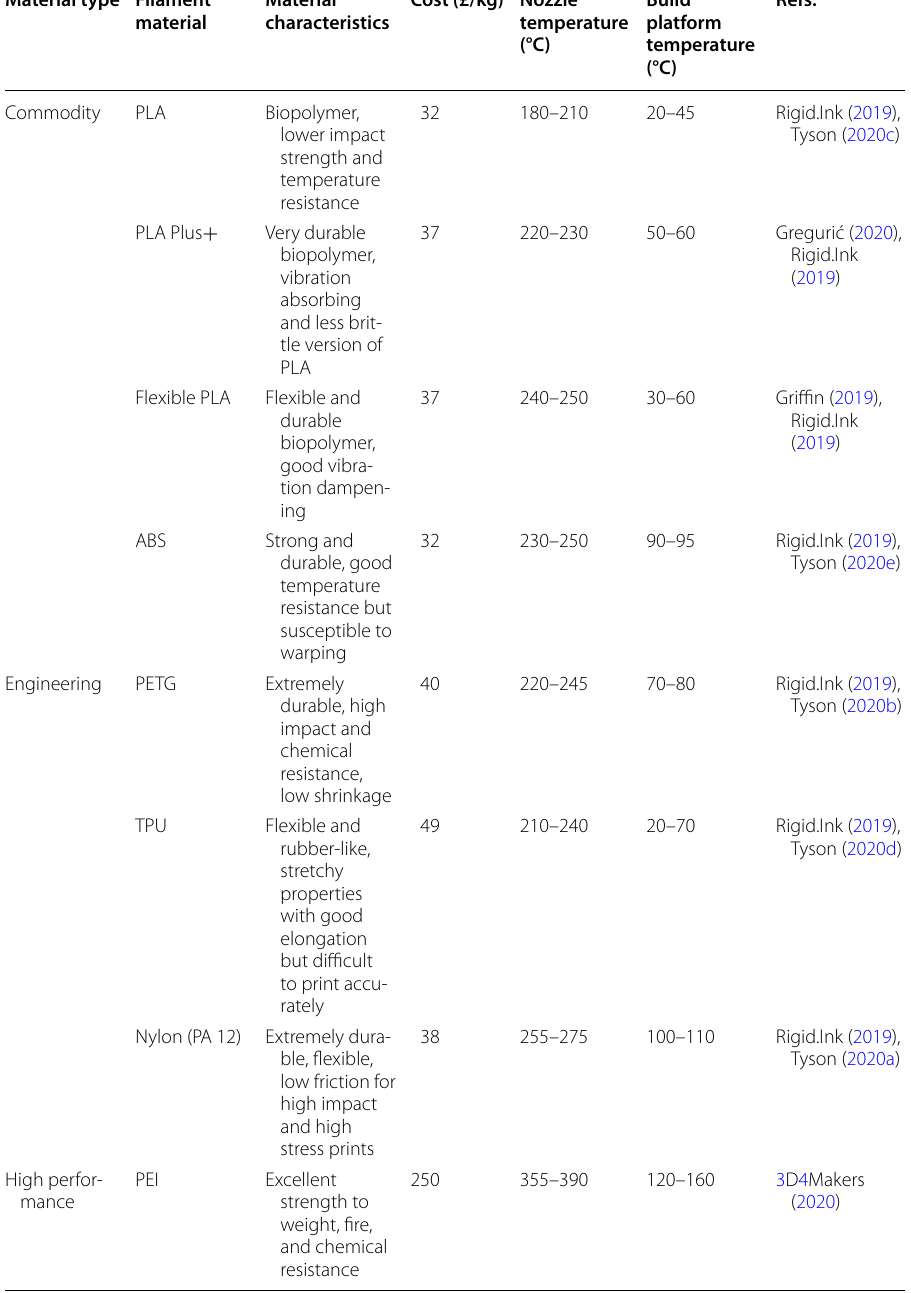
Table 2 Common thermoplastics used in ME and their properties Material type Filament